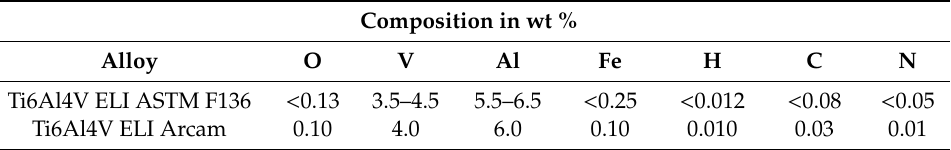
Table 2. Chemical composition of Arcam